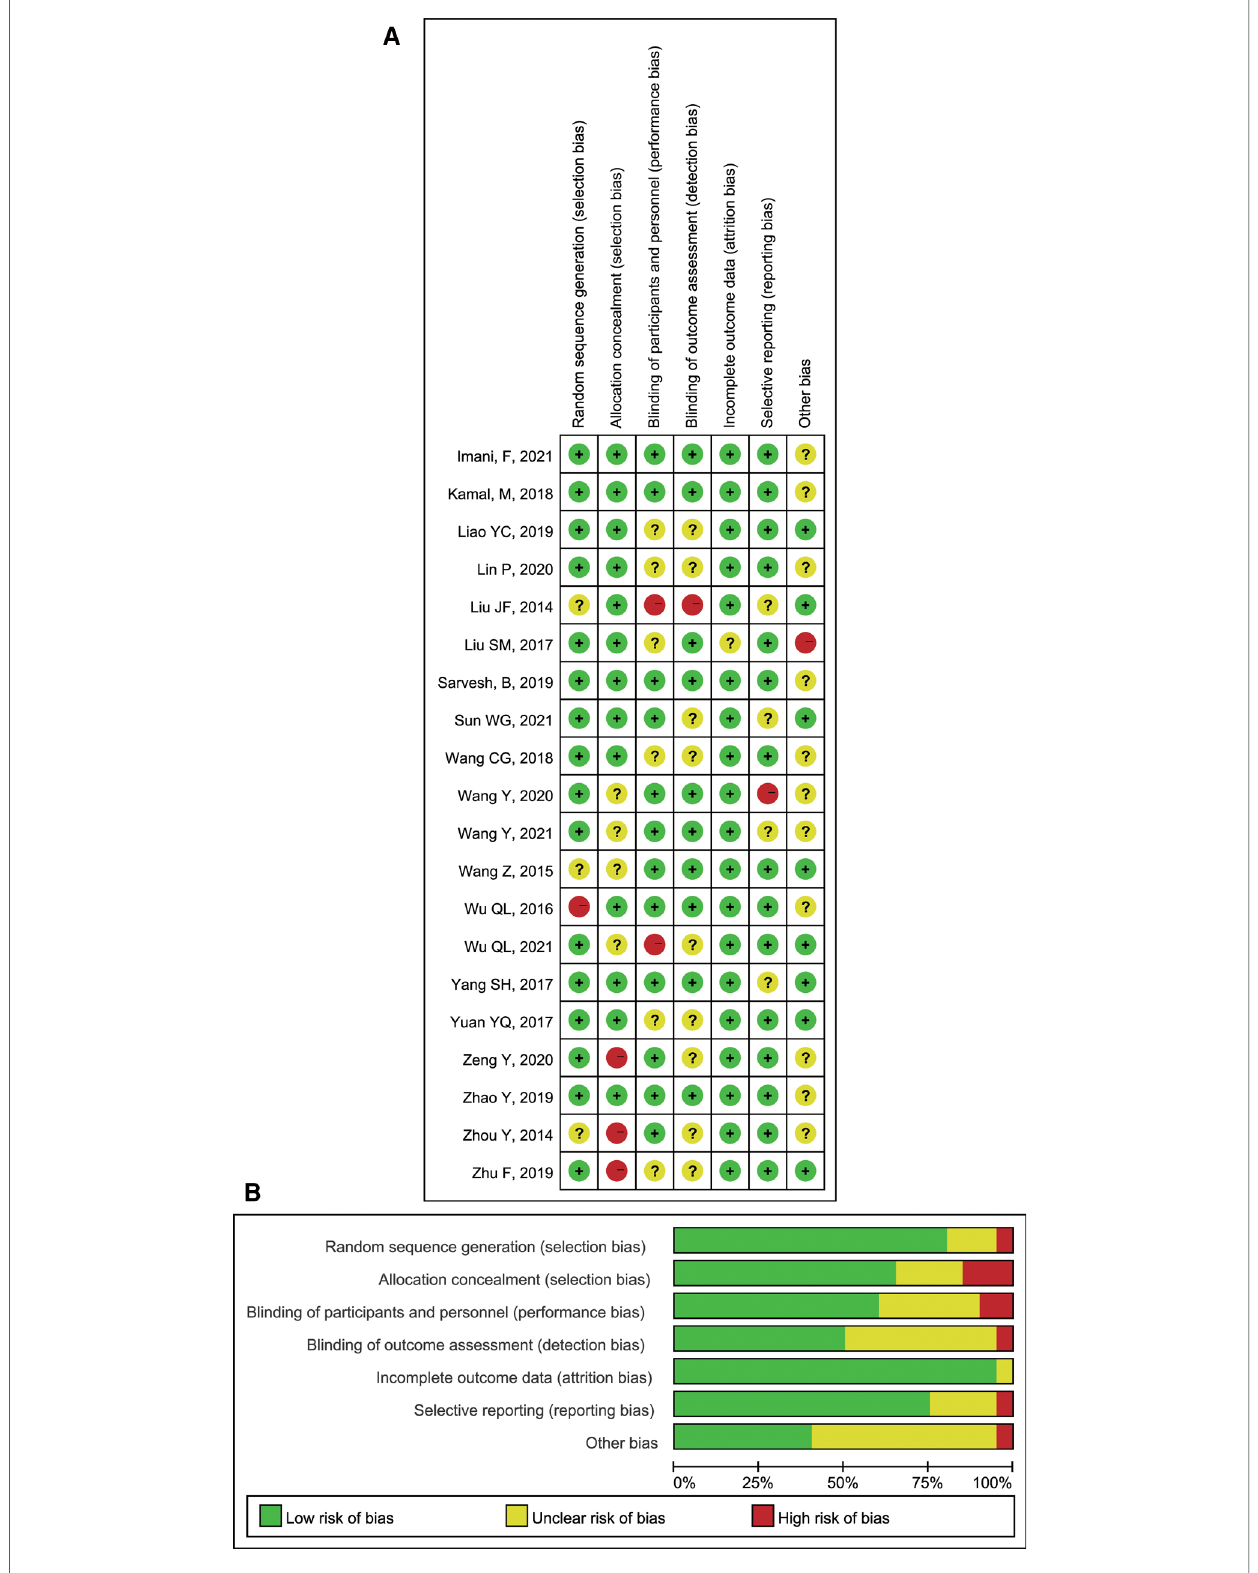
FIGURE 2 Review authors ’ judgements: ( A ) Risk of bias summary; ( B ) Risk of bias graph presented as percentages.